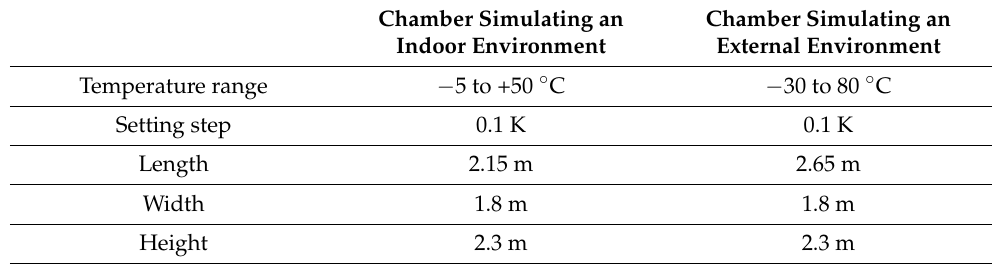
Table 1. Climate chamber parameters.